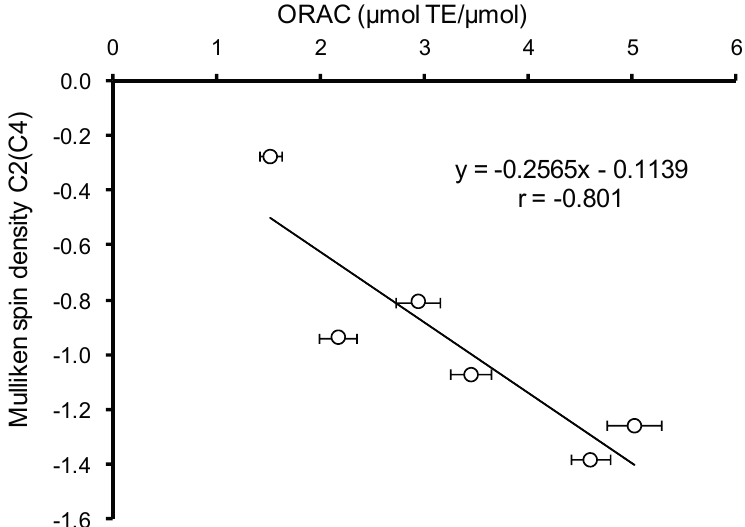
y = -0.2565x - 0.1139 r =